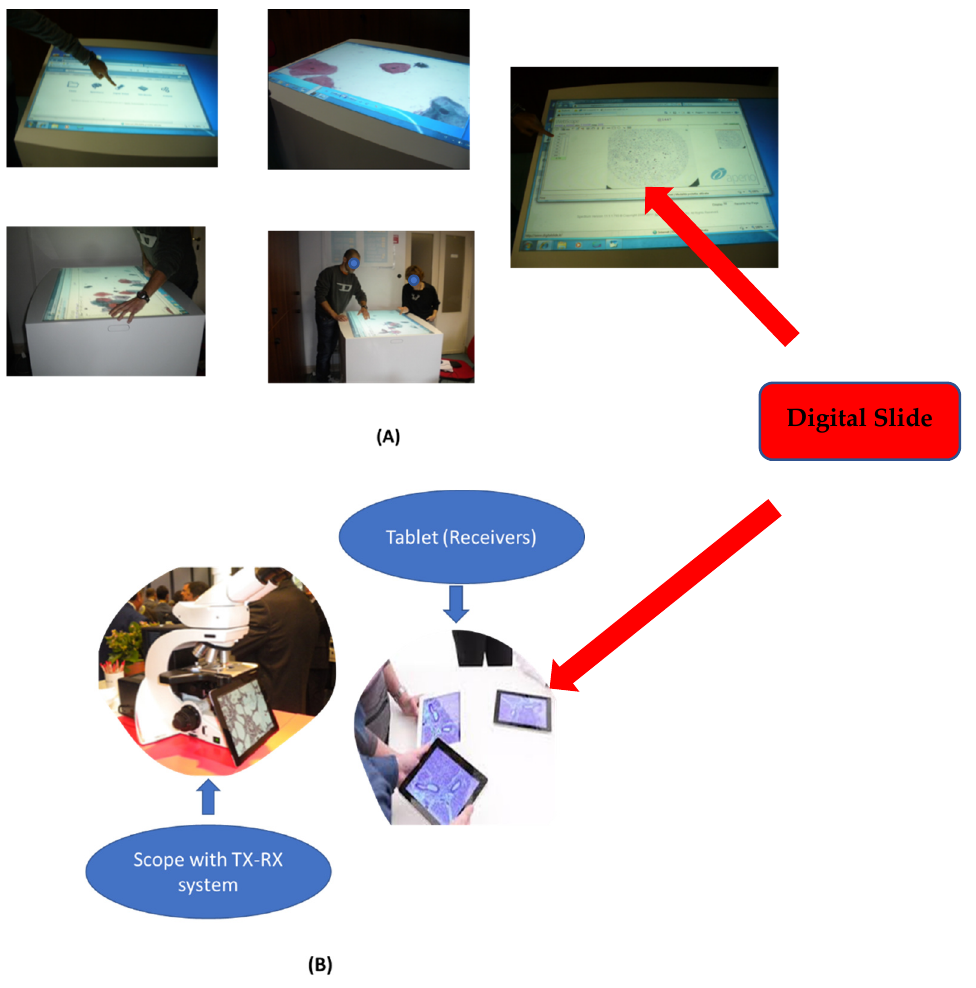
Figure 4. The two different types of training: ( A ) using a very large tablet; ( B ) using the DMSHARE.